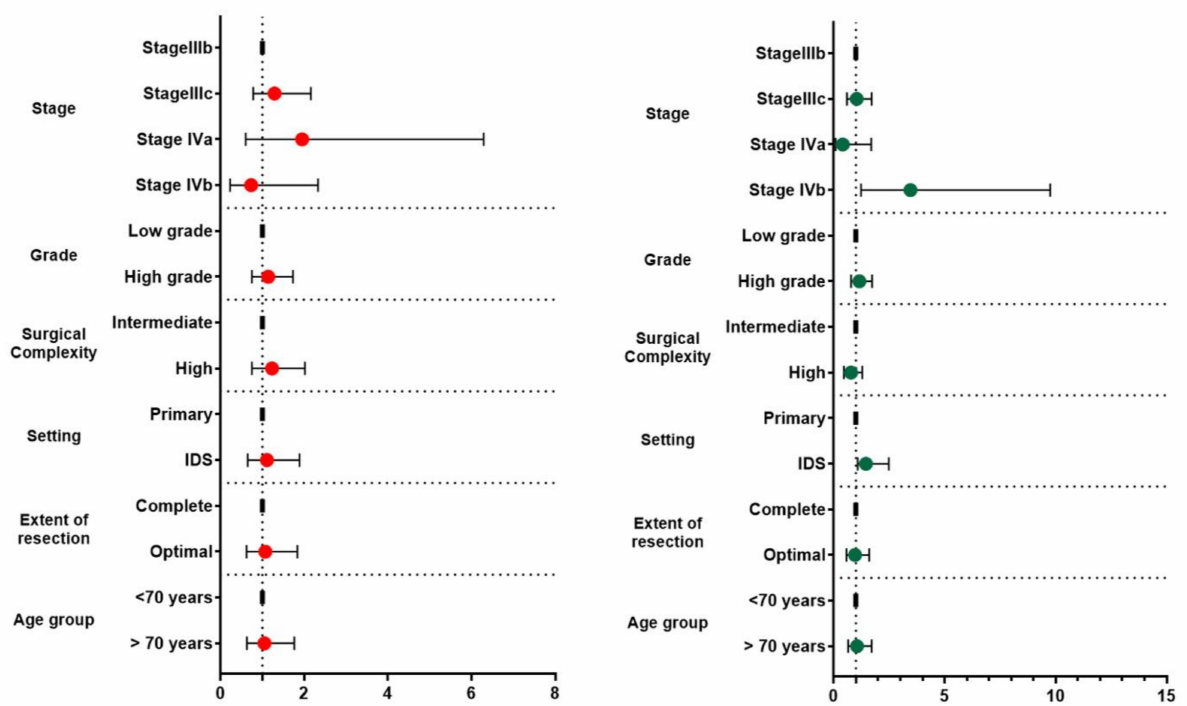
Figure 2. Forest plots of hazard ratios and 95% CIs of factors affecting progression-free (right side—red dots) and overall survival (left side—green dots)